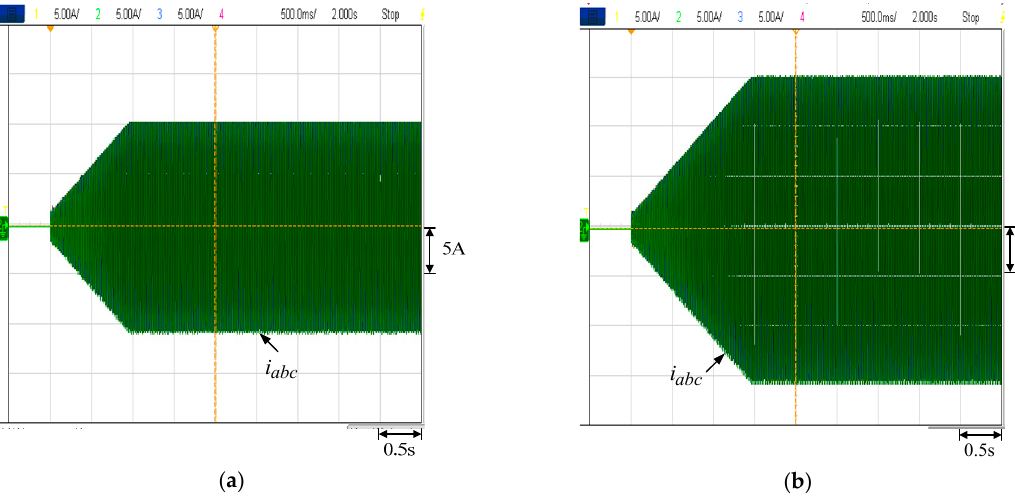
Figure 7. Winding current waveforms of the current command goes from zero to a constant value at 1200 rpm: ( a ) 10 A; ( b ) 15 A.